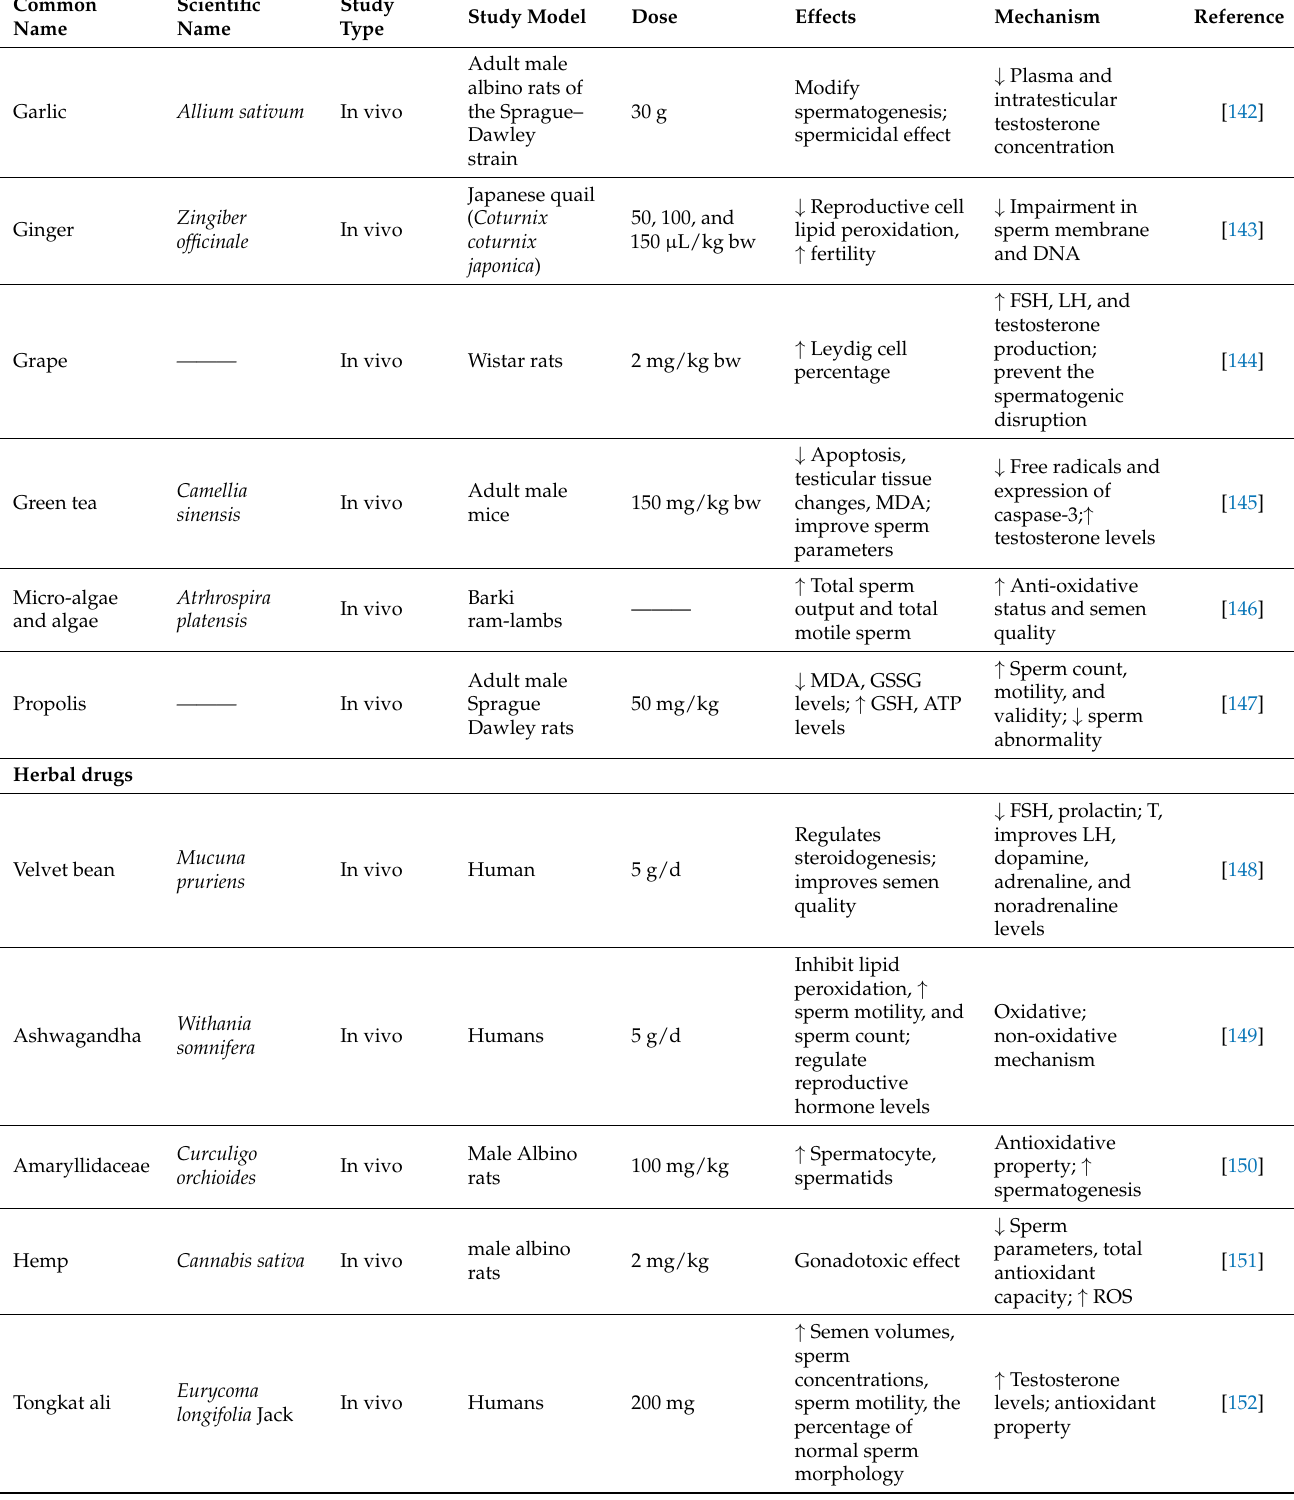
Table 1. Effects of SARS-CoV-2 on various male reproductive parameters leading to male